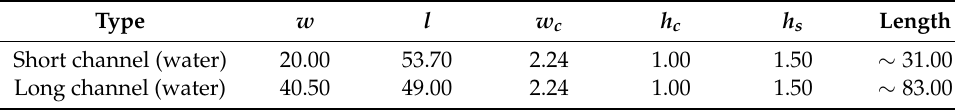
Figure 4. Scattering parameters obtained from simulation of the long-channel LTCC module: ( a )—magnitude of S 11 ( S 22 ), ( b )—magnitude of S 21 ( S 12 ). The structure is electrically symmetric. Table 1. LTCC sensor modules basic dimensions (mm).